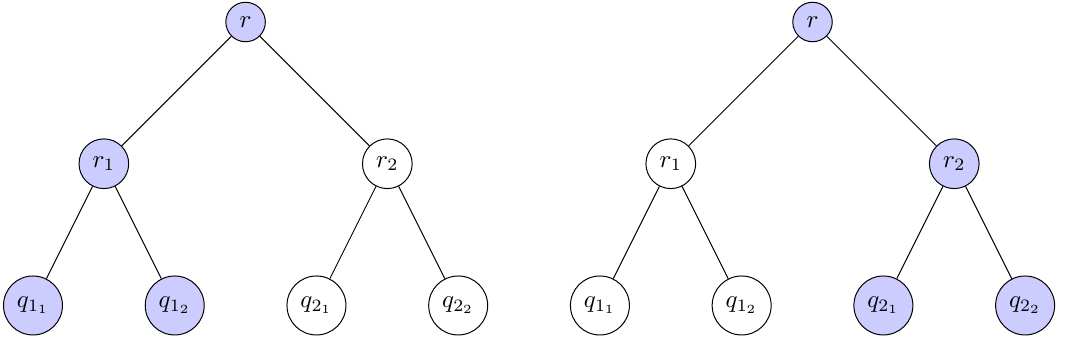
Figure 2: These two subsets of size 4 are the only ones that fail to be power dominating